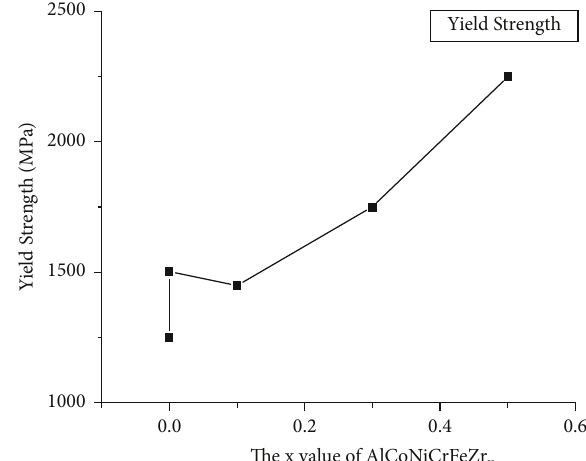
Figure 7: Stress–strain curves of AlCoCrFeNiZr pressive) [12].